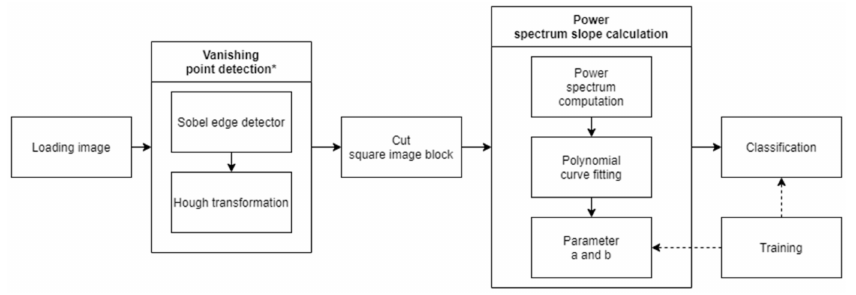
Figure 6. Flowchart of the fog detection algorithm proposed in